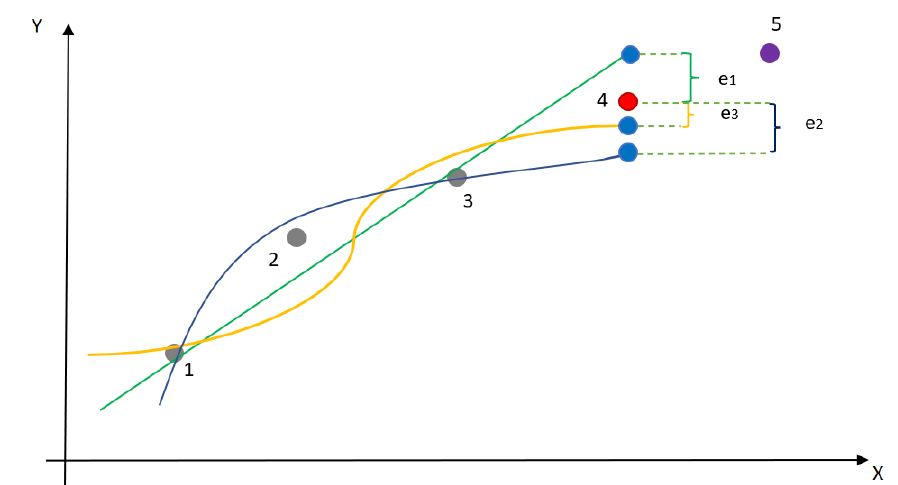
Figure 4. Example of how the polynomial integration